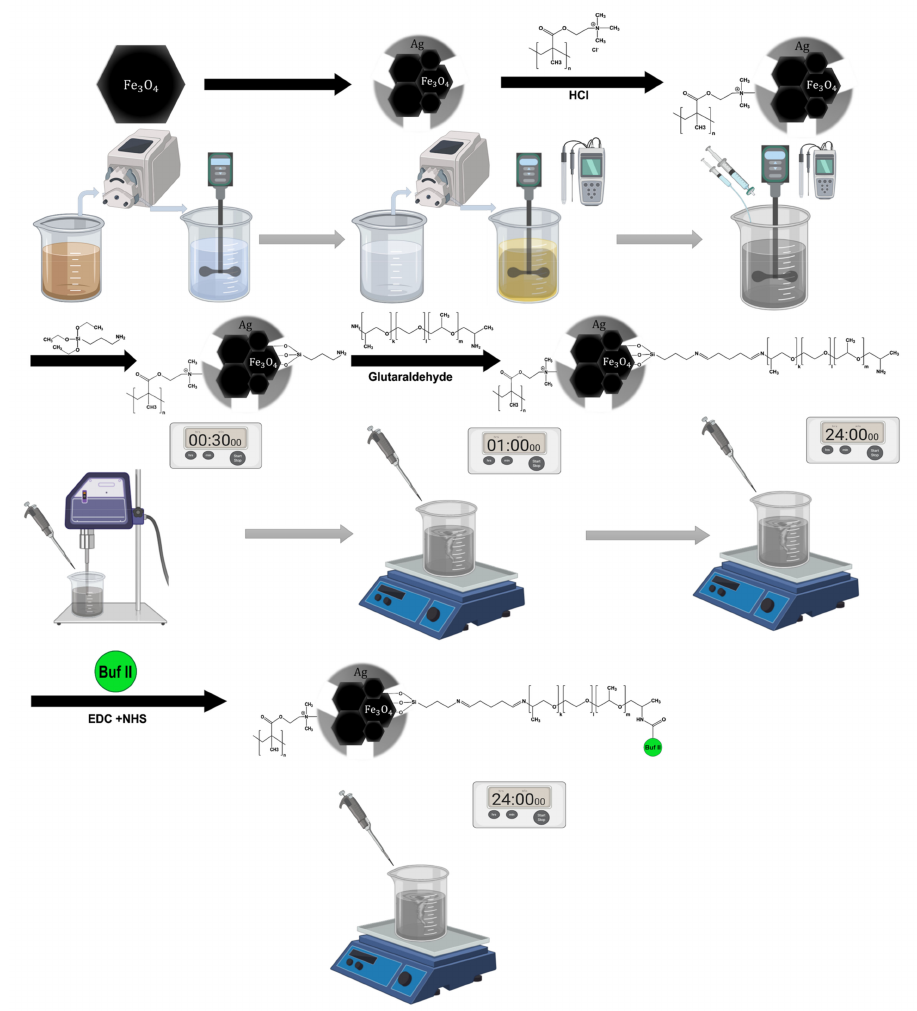
Figure 1. Graphical methodology. The figure represents the steps followed in the synthesis and immobilization of the vehicle. First, magnetite was synthesized using the co-precipitation method. Second, the silver coating was made by using a redox reaction with control of the pH. Third, the pDMAEMA was immobilized on the core / shell magnetite / silver surface, stirring, and the pH was carefully controlled. Finally, the conjugation of Buforin II, using the Polyether Amine, Je ff amine ® , as a surface spacer and APTES to anchor the molecules on the